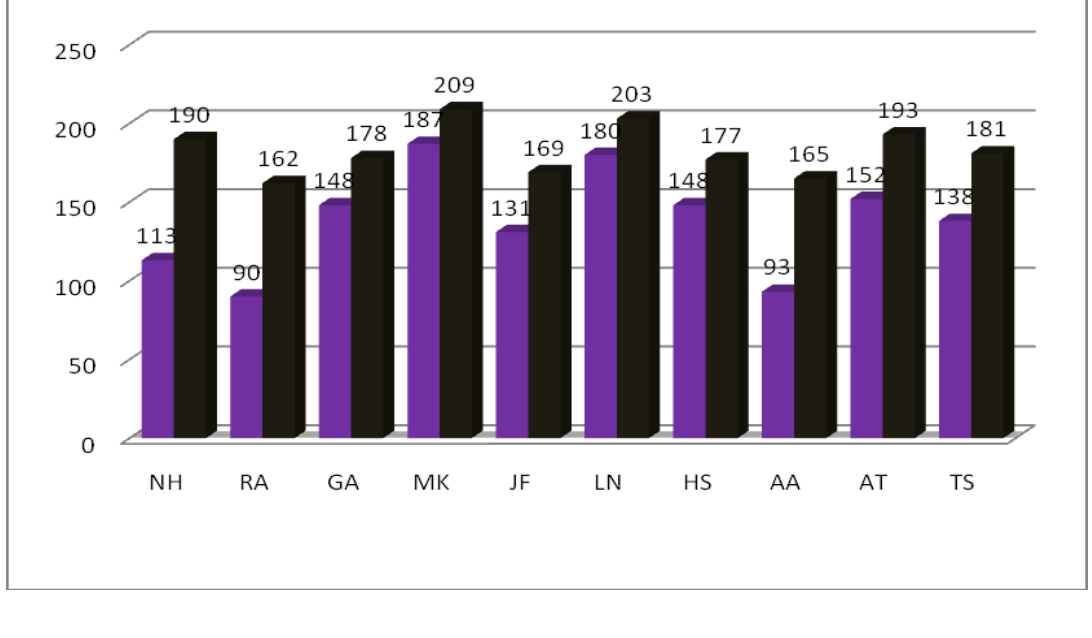
Figure 1.1 Graph Acquisition Total Score Initial Evaluation and Final Evaluation 10 student (experimental